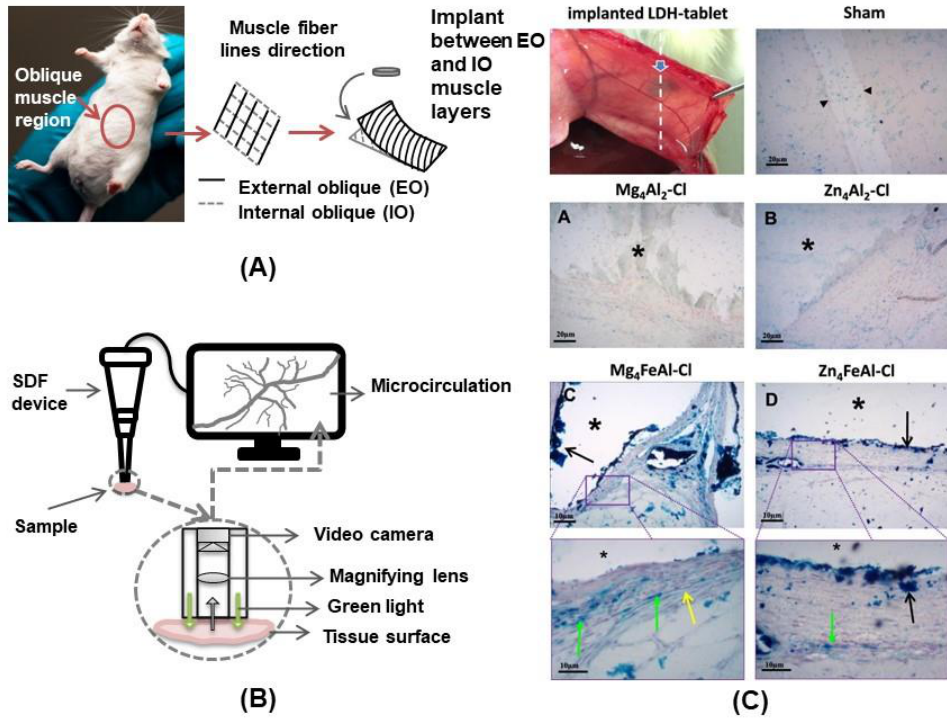
Figure 11. Schematic illustration of ( A ) LDH tablet implanted in the intramuscular abdominal region of rats and ( B ) microcirculation monitoring by SDF videomicroscopy image (both figures reprinted from Constantino et al. [152] with permission of World Scientific Publishing Co.); ( C ) Iron histochemistry findings following A-Mg 4 Al 2 -Cl LDH, B-Zn 4 Al 2 -Cl LDH, C-Mg 4 FeAl-Cl LDH and D-Zn 4 FeAl-Cl LDH tablets implants between abdominal wall intermuscular spaces, after 28th P.O. The white dotted line with the blue arrow indicates the macroscopic appearance of the implanted LDH tablet and the cut line for histological processing. LDH tablet (*); positive staining ( → arrow black); positive staining in fibroblast ( → arrow green); positive staining in ECM matrix ( → yellow); perimysium between abdominal wall muscle layers ( ► ). Prussian blue staining (reprinted from Figueiredo et al. [143] with permission of American Chemical Society).